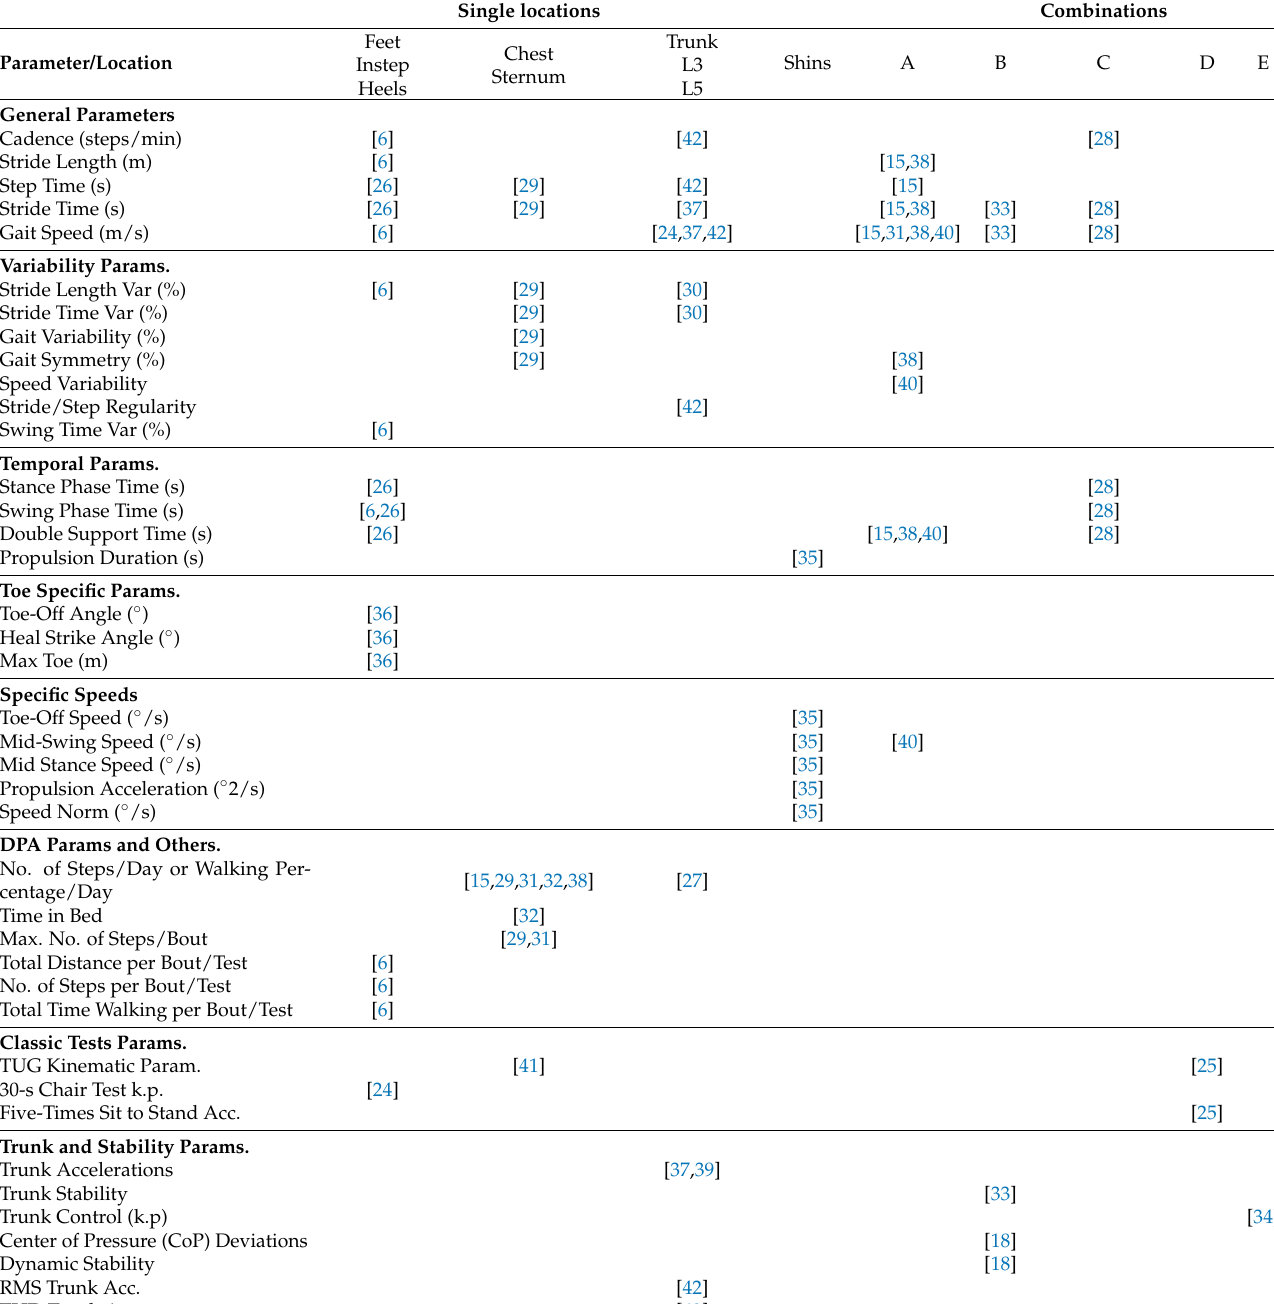
Table 6. Summary of sensor’s body location, gait parameters, and paper’s references. Single locations: sensors located at a single body position. Combination: sensors are located at two or more body positions, where: A = shins/shanks + thighs + lower back/trunk; B = shanks + pelvis/L5; C = thighs + shins + feet; D = shins + thighs + L5 + sternum; E = wrist + ankles + L5 +